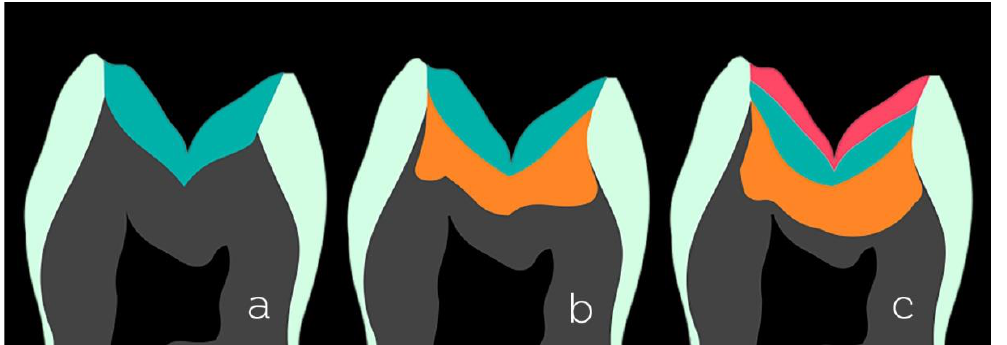
Figure 3. Different restorative techniques using conventional resin composites based on the number of shades used (represented by dark green, orange, and red colors): monochromatic ( a ), bichromatic ( b ), and polychromatic ( c ).